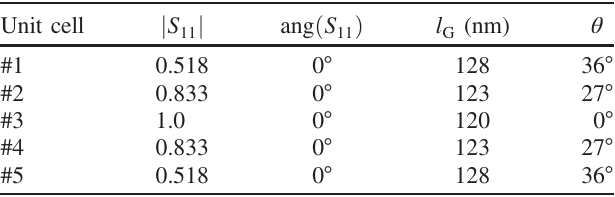
TABLE II. Normalized reflection coefficients of each unit cell in a five-element Dolph-Tschebyscheff reflectarray that reflects a normally incident plane wave at its